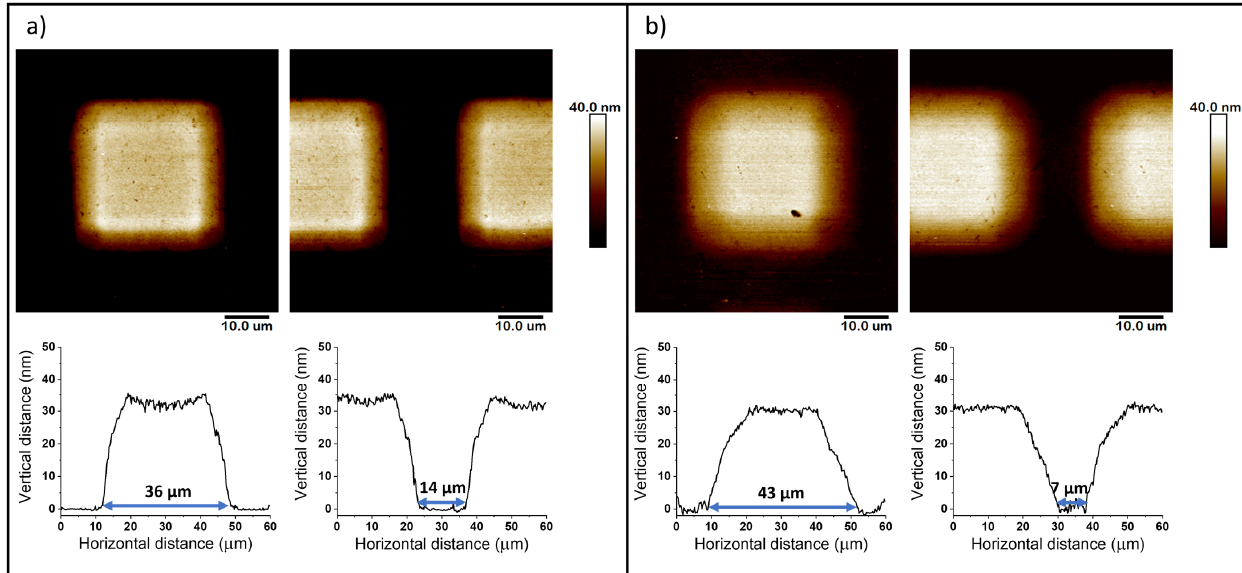
Figure 10. AFM images with corresponding cross-section profiles of patterned PMTM brushes synthesized by metal-free SI-ATRP by placement of the TEM grid with ( a ) shiny side faced to LED lamps and ( b ) matte side faced to LED lamps.